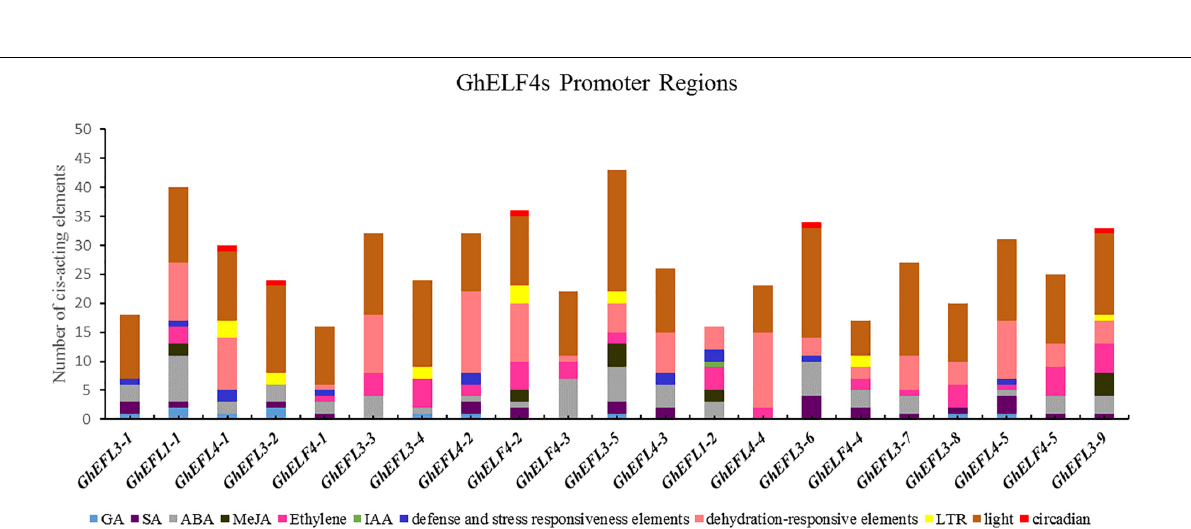
Frontiers in Genetics |